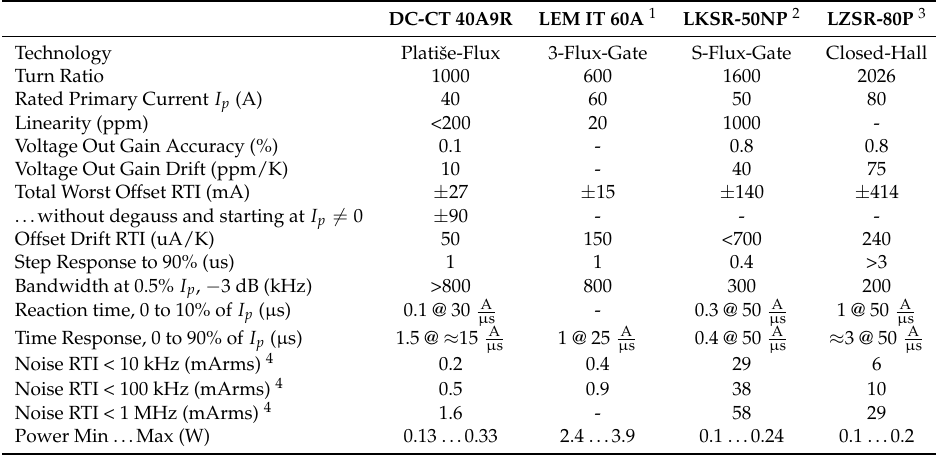
Figure 11. Accuracy of the 40A9R core. ( a ) Hysteresis and linearity; ( b ) Temperature stability at 25 A; ( c ) Cycling at the rated range after degaussing is applied; ( d ) Cycling at the rated range without degaussing. Table 3. Performance comparison of similar current transducers and different